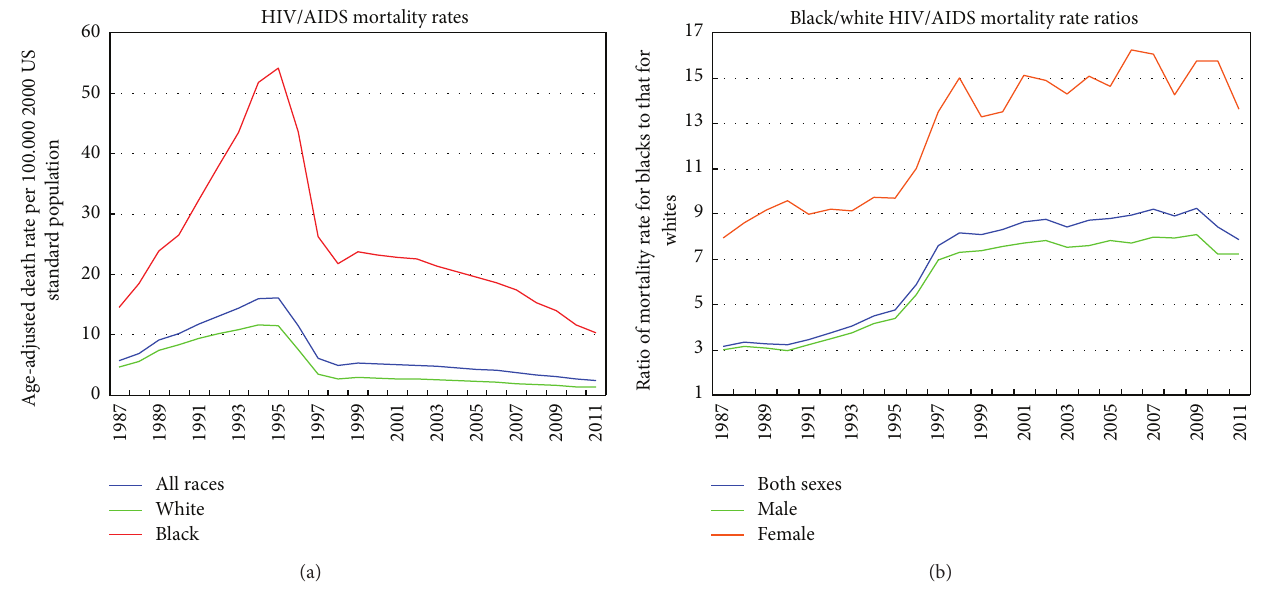
Figure 2: Trends in age-adjusted HIV/AIDS mortality rates and rate ratios by race, United States, 1987–2011. [25, 26]. Poisson regression models, as estimated by the SAS GENMOD procedure, were used to derive relative risks of HIV/AIDS mortality using the same covariates as in the